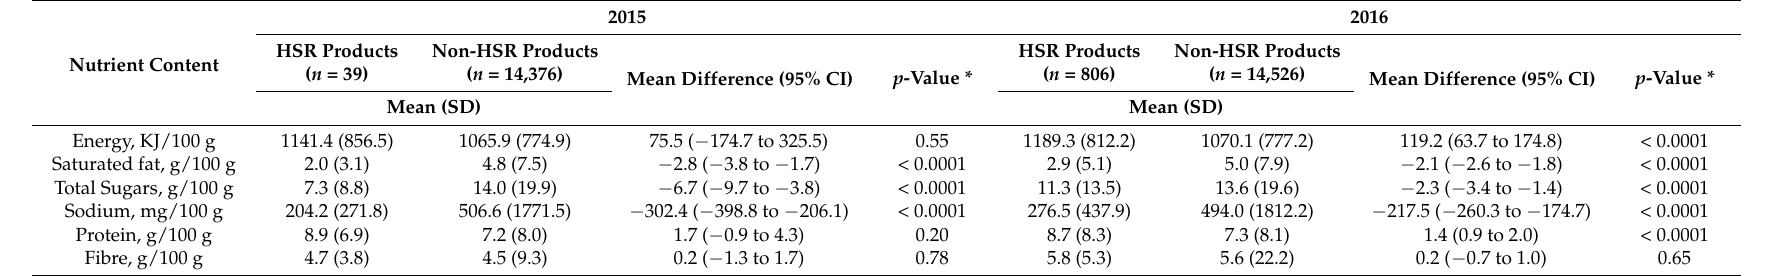
Table 1. Nutritional composition of foods by Health Star Rating (HSR) status, in 2015 and